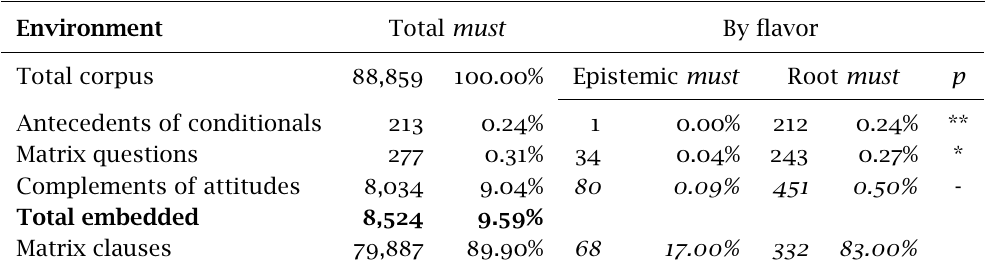
Distribution of epistemic and root must in various environments: ** p < 0 . 001 , * p < 0 . 05 , - p > 0 . 05 , Fisher’s exact test. Compares the distribution of epistemic and root must in each embedded environment to must ’s distribution by flavor in a sample of 400 matrix declaratives (italicized). ‘Complements of attitudes’ comprises a random sample of 400 verb complements and all 134 adjective complements